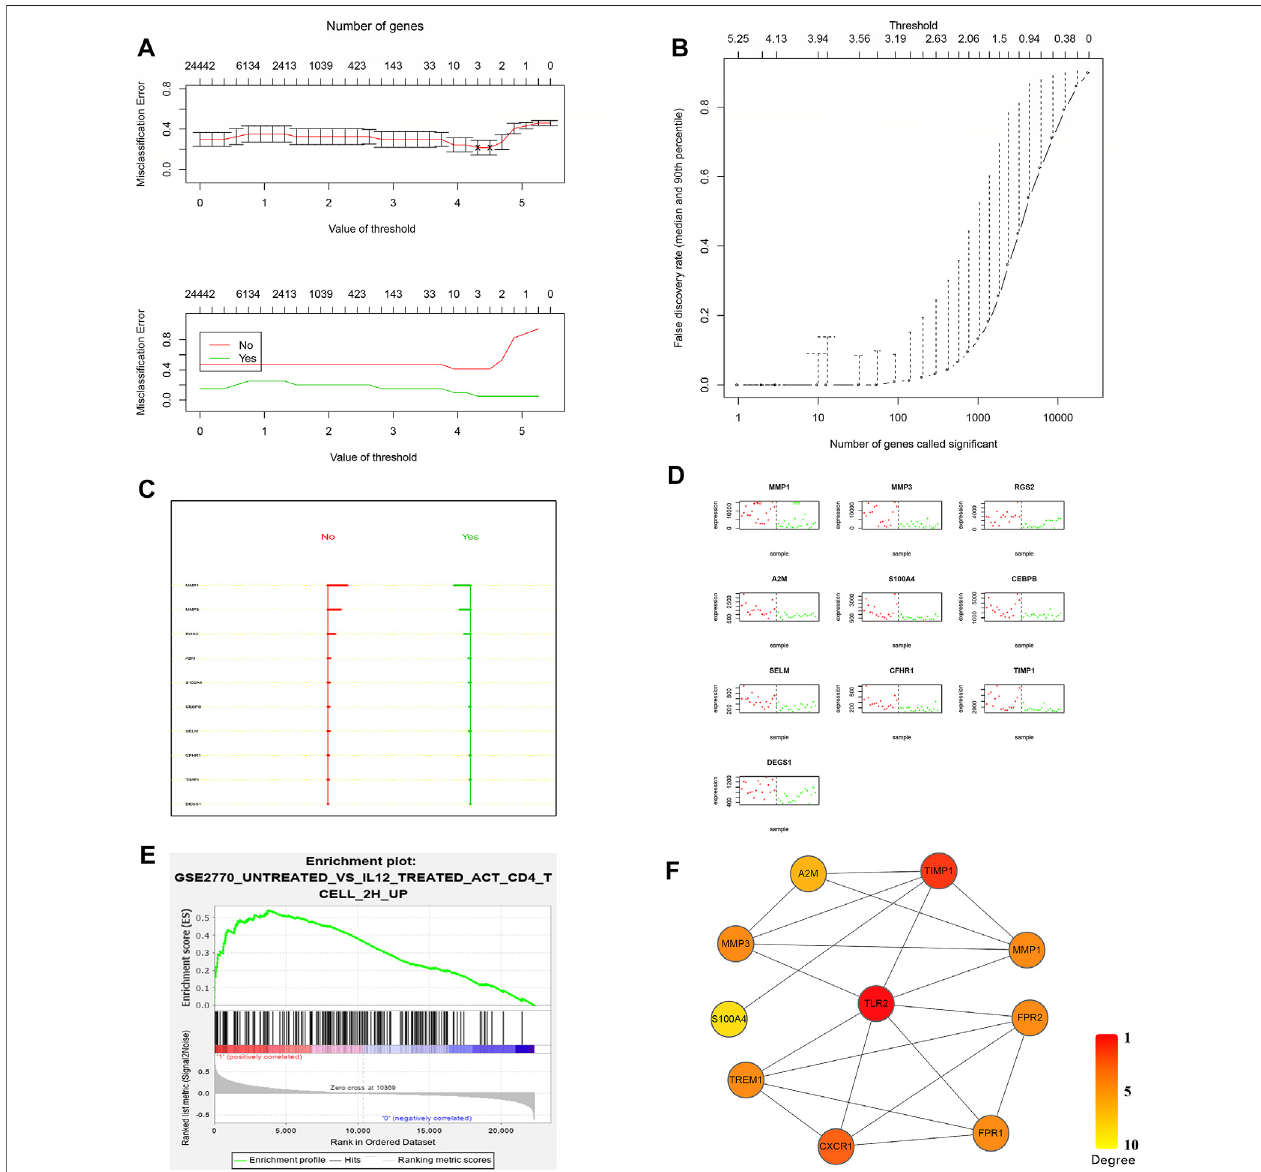
FIGURE 3 | Con fi rmation of the core predictors after screening. (A) Misclassi fi cation error analysis under the PAM predictive model and model gene number. (B) Curve of the false discovery rate. The lowest false rate was observed when the threshold was 3.938 in the PAM model. (C) No-score (nonresponders) and yes-score (responders) for the best classi fi ed genes, supporting the favorable predictive value when the range widened. (D) Actual classi fi cation effects of these 10 risk genes. (E) Third-ranked GSEA results from GSE16879 nonresponders. The gene set was a Th1 immune response gene set in the database. (F) The core scoring network from CytoHubba for combined top differentially expressed genes and lowest misclassi fi cation